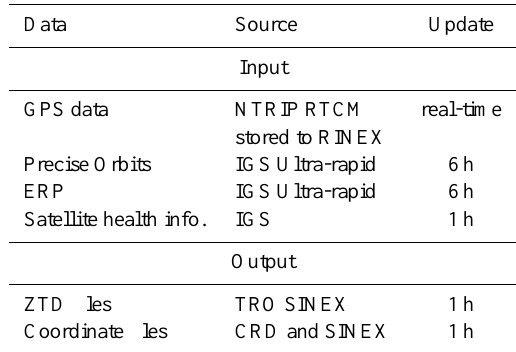
Table 2. Input data for the NRT processing of ZTD at Institute of Geodesy and Geoinformatics in